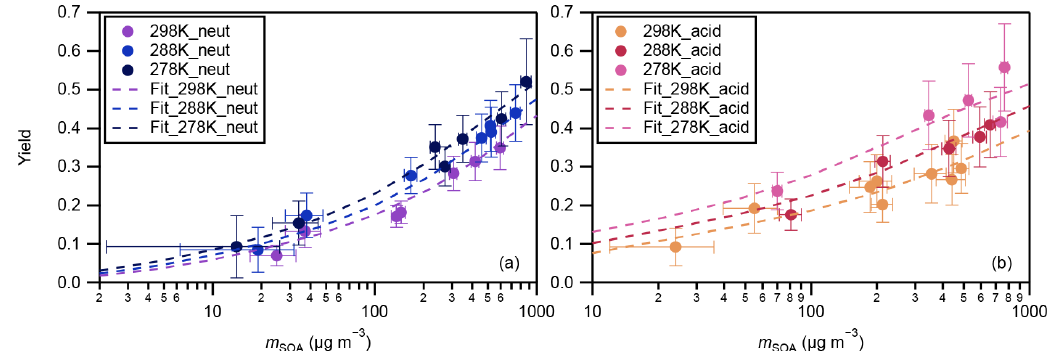
Figure 3. Mass yields of SOA for increasing SOA mass loadings. Markers and whiskers are measured data and their uncertainties (Text S4; the uncertainties of the data during the reaction time of 85–90min are presented); dashed curves are fitting of measured data using a four- product VBS model (Donahue et al., 2006; Lane et al., 2008). Panel (a) presents results under neutral seed conditions, and panel (b) presents results under acidic seed